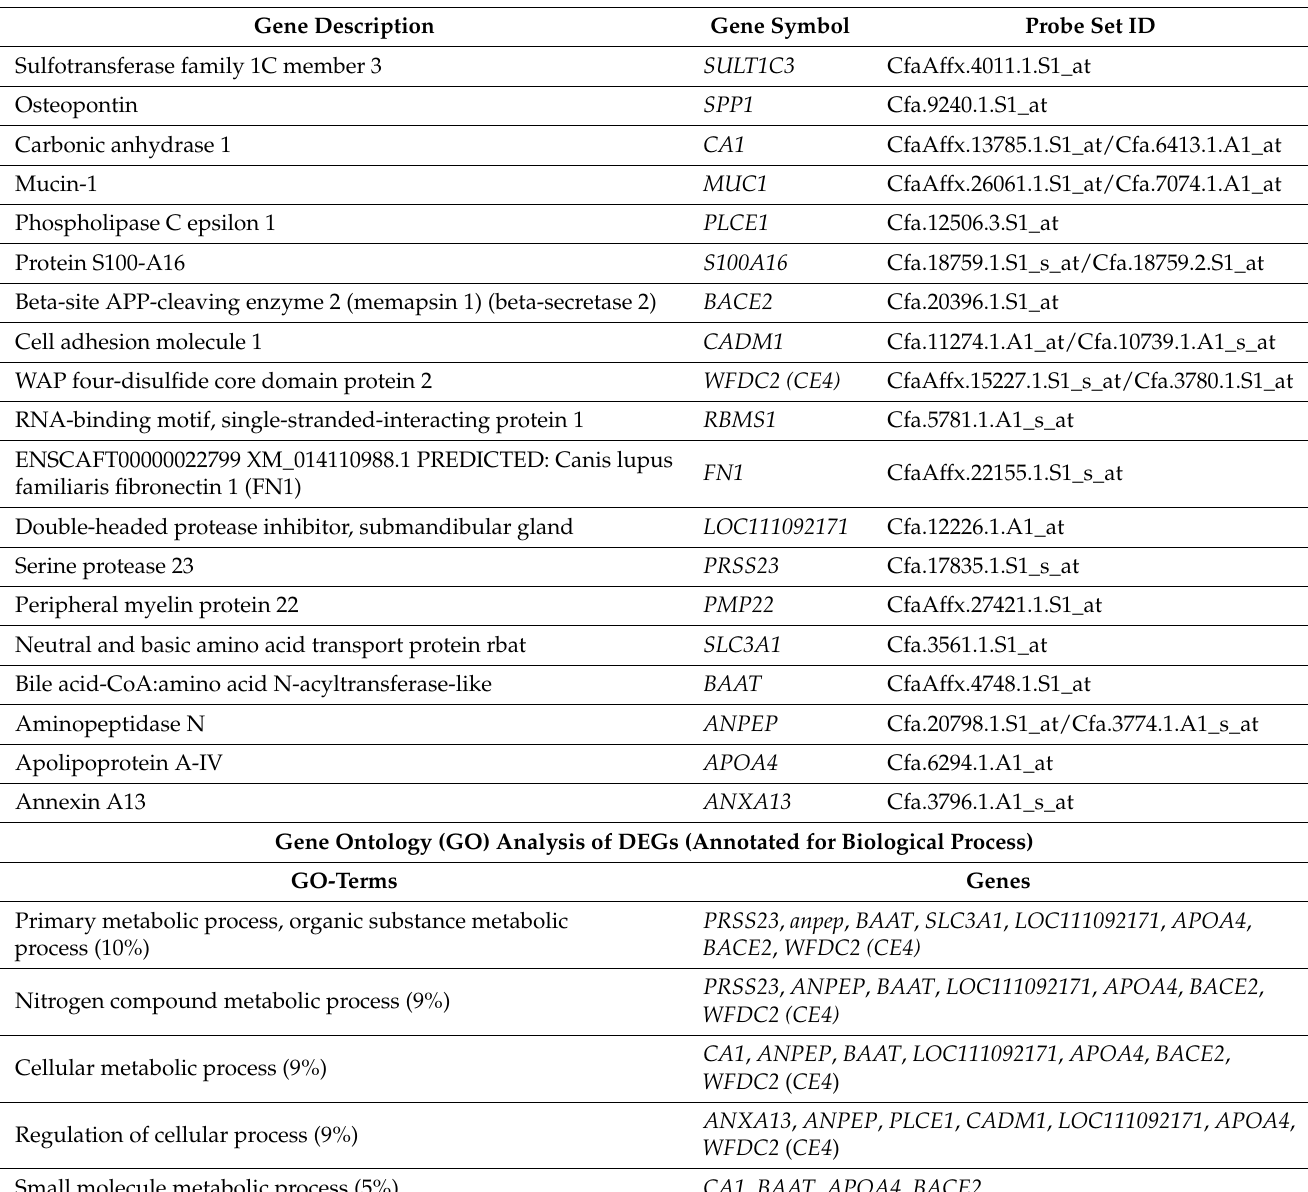
Table 8. The Gene Ontology (GO) analysis and details about the top 14 upregulated and five downregulated DEGs in the control IBD enteroids vs. the control tumor enteroids. The DEGs annotated for the biological process, molecular function, and cellular component categories are shown. The percentages represent the number of genes in each functional